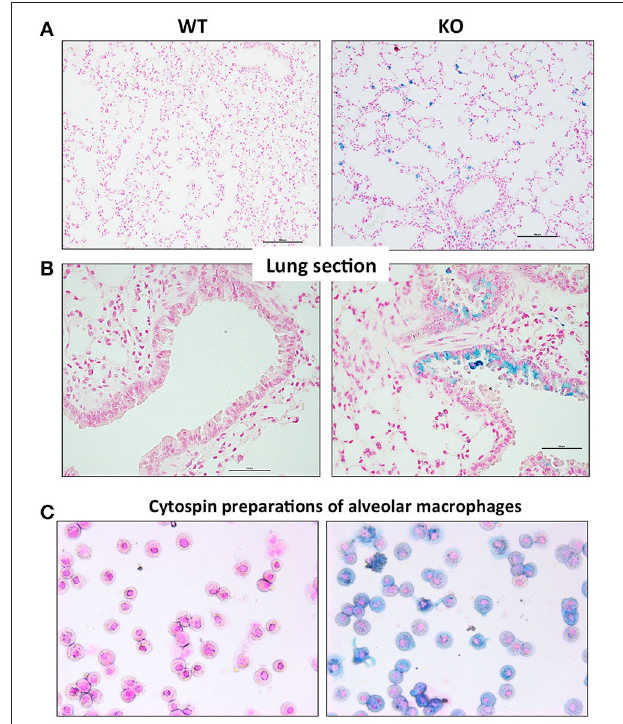
FIGURE 3 | Perls’ blue staining of lung section from WT and Hepc KO mice: Iron deposition was visualized using Perls’ blue staining in lung section. The scale bars indicate 50 µ m (A) and 100 µ m (B) . Representative images of BAL (bronchoalveolar lavages) cytospin slides obtained from WT and Hepc KO mice and stained with Perls’ Prussian blue (C)